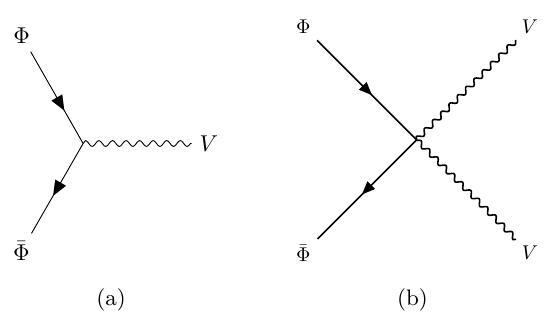
Figure 1 . Vertices with three and four external lines arising from the interacting term in eq. (4.6). The vertex (a) has coupling g , while the vertex (b) has coupling g 2 / 2